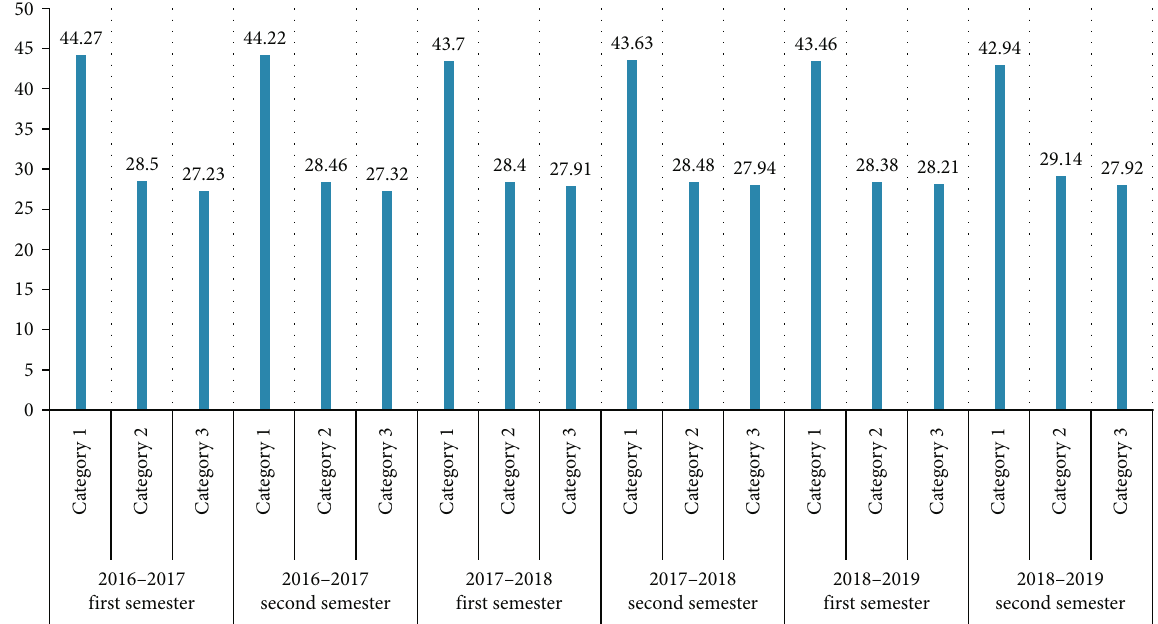
Figure 6: Histogram of the percentage of teachers in the three categories at school Y .